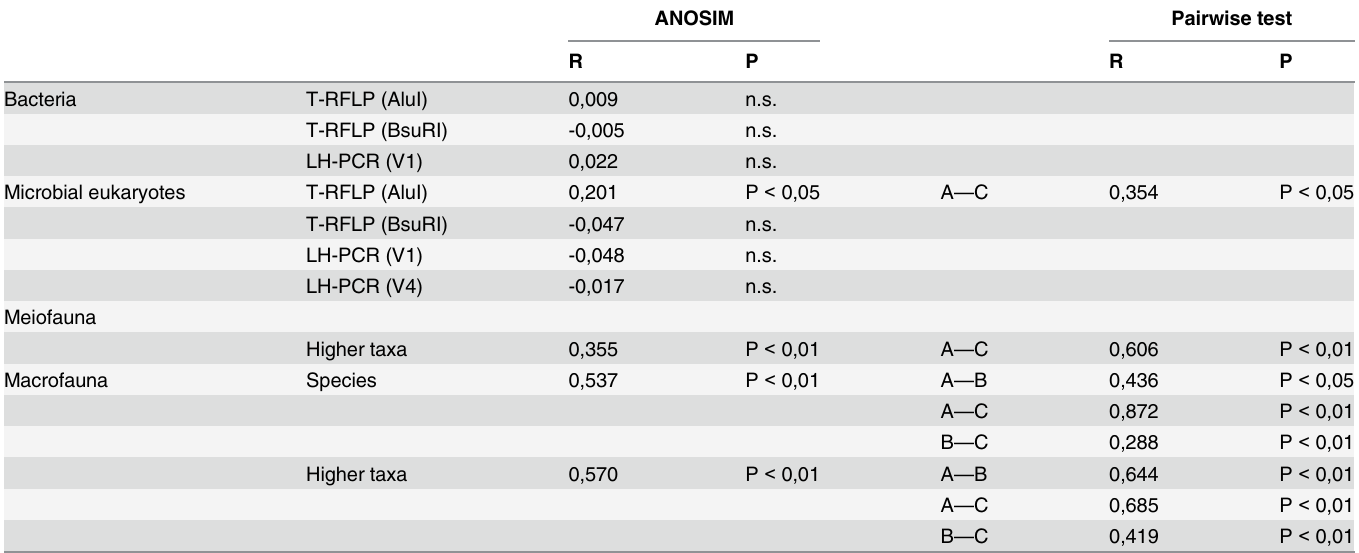
Table 1. Results of ANOSIM and pairwise test of data obtained from communities at the different size levels in the three areas (A, B, C). For the pair- wise test, only significant results are